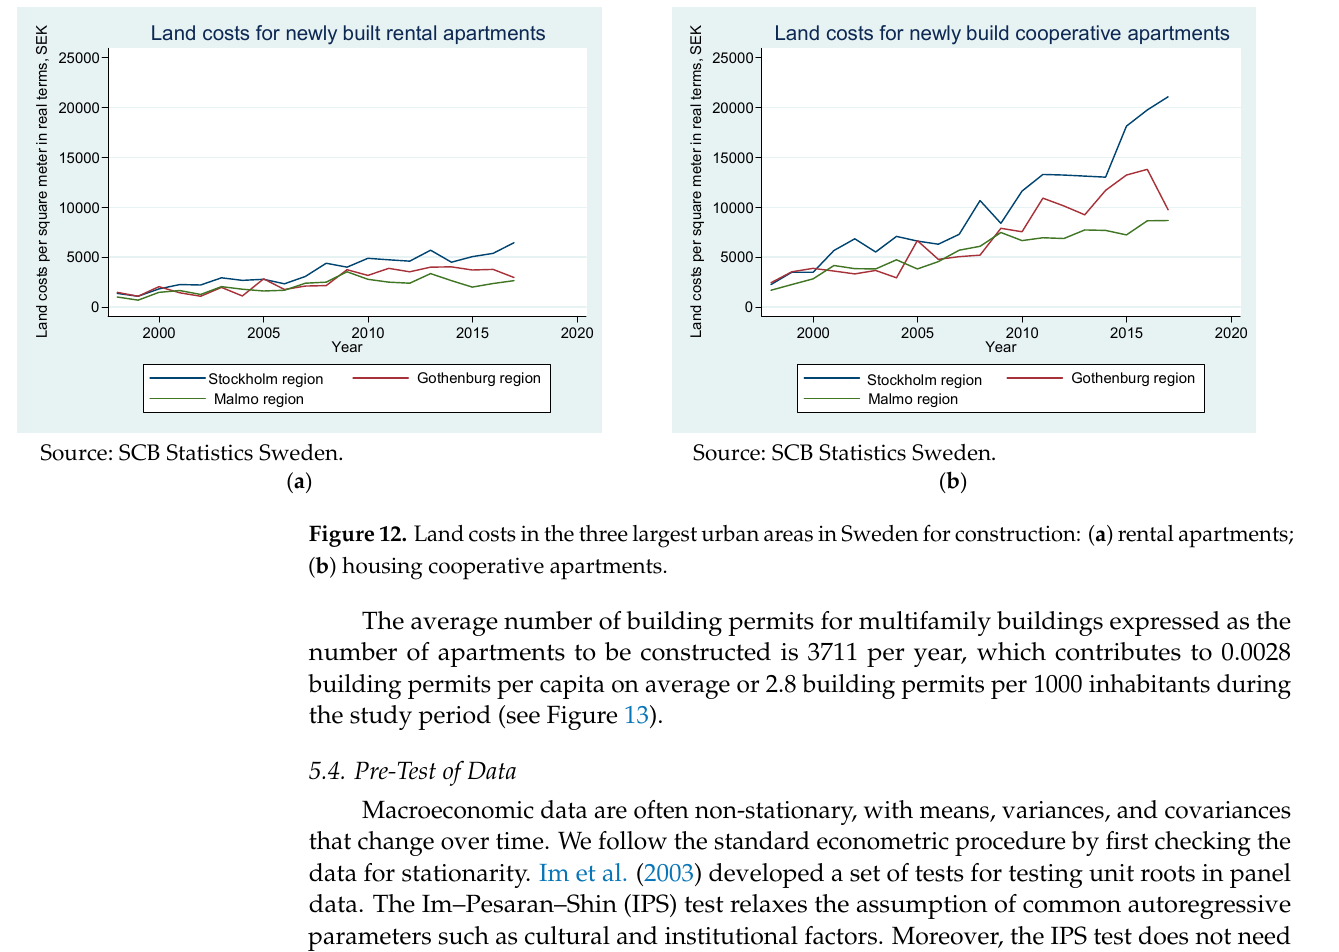
Figure 11. Price for cooperative apartments in the three largest urban areas in Sweden. The average land cost per square meter for newly built rental apartments is SEK 2767, which is 2.7 times less than that for cooperative apartments, which is SEK 7454 per square meter (see Figure 12).